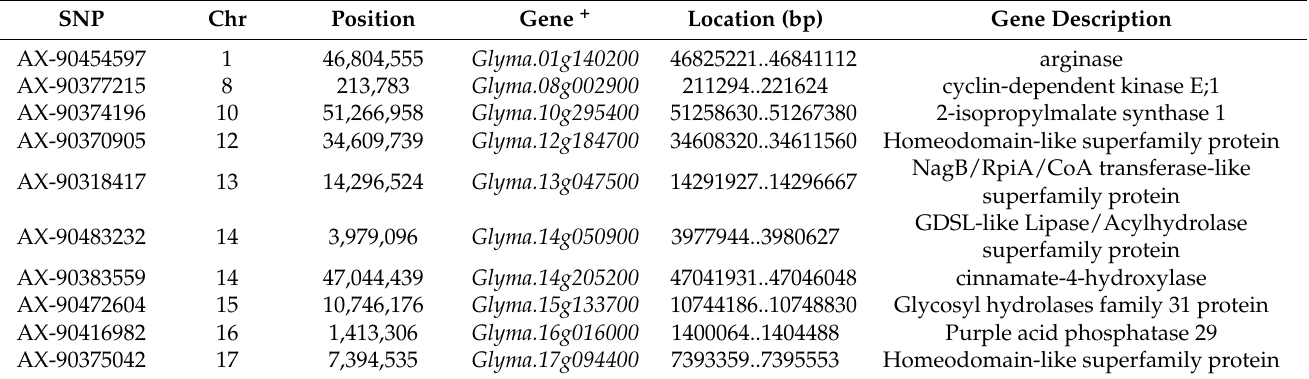
Table 7. Candidate genes associated with 100SW in wild